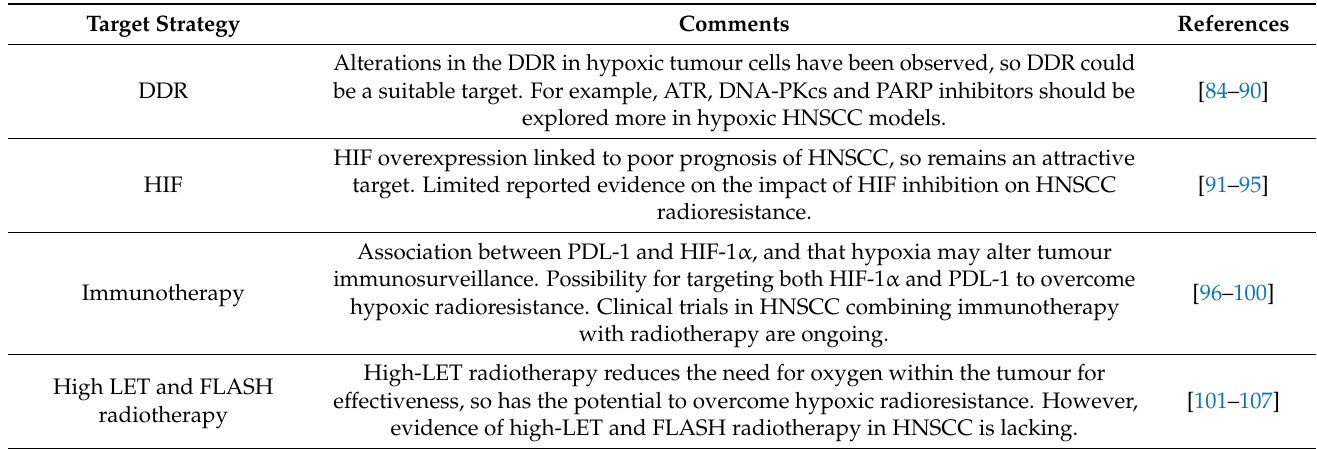
Table 2. Current and future strategies to overcome hypoxia induced radioresistance in